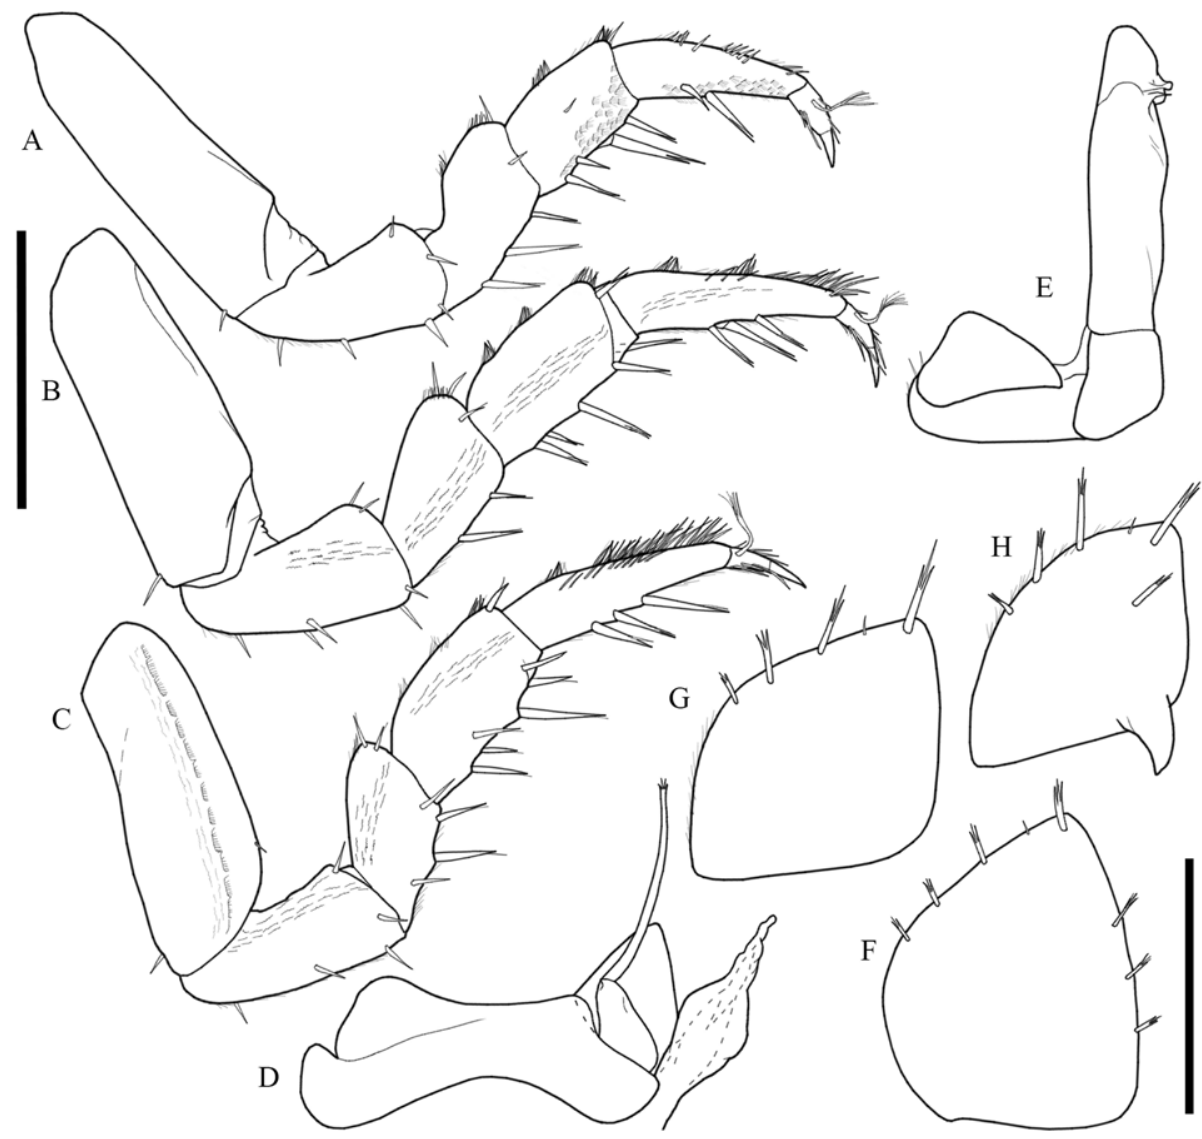
Figure 6. Pectenoniscus juveniliensis n. sp. Male paratype: A , pereopod 1; B , pereopod 6; C , pereopod 7; D , genital papilla and pleopod 1; E , pleopod 2; F , pleopod 3 exopod; G , pleopod 4 exopod; H , pleopod 5 exopod. Scale bars: 0.2